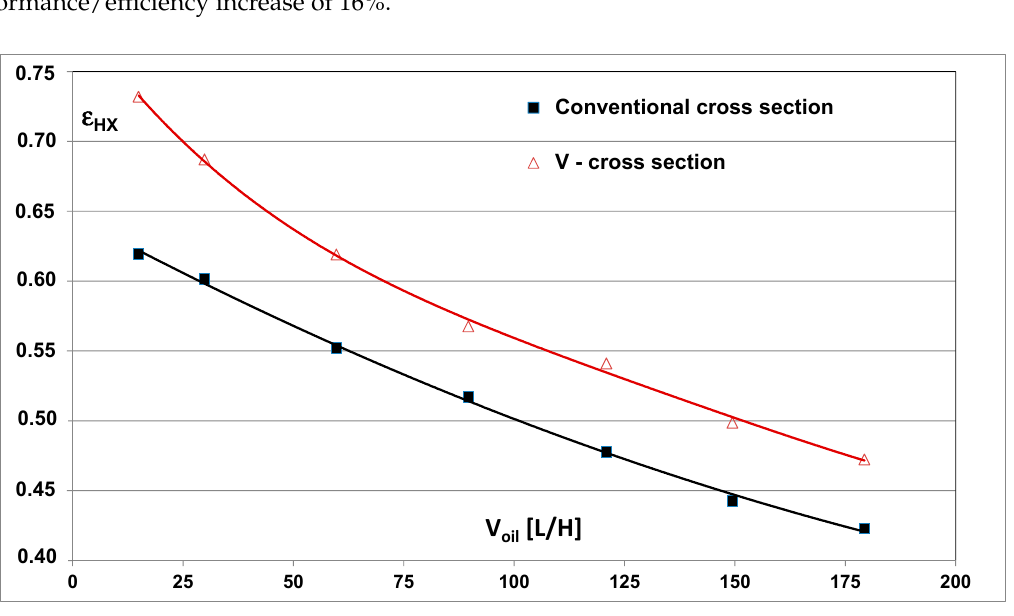
Figure 23. The average temperatures in the outer ring at 120 L/H oil flow and 80 °C oil temperature. In the first two fin rows the temperature gradient in the fin is 54 K.